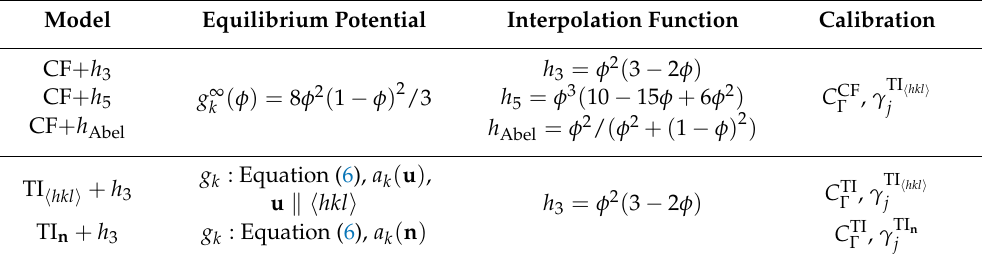
Table 2. Overview of the considered models constructed within the unified finite difference (FD) framework.